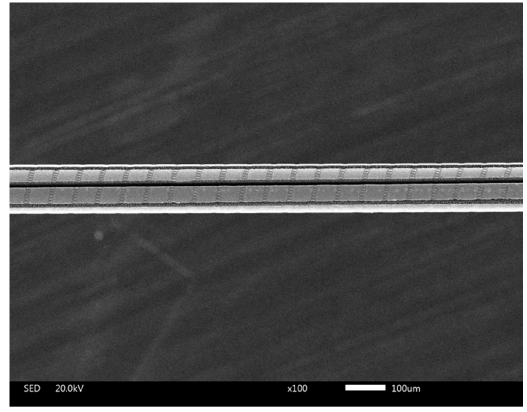
Figure 3. SEM figure of Pd/Ag thin film deposited onto composite structure.